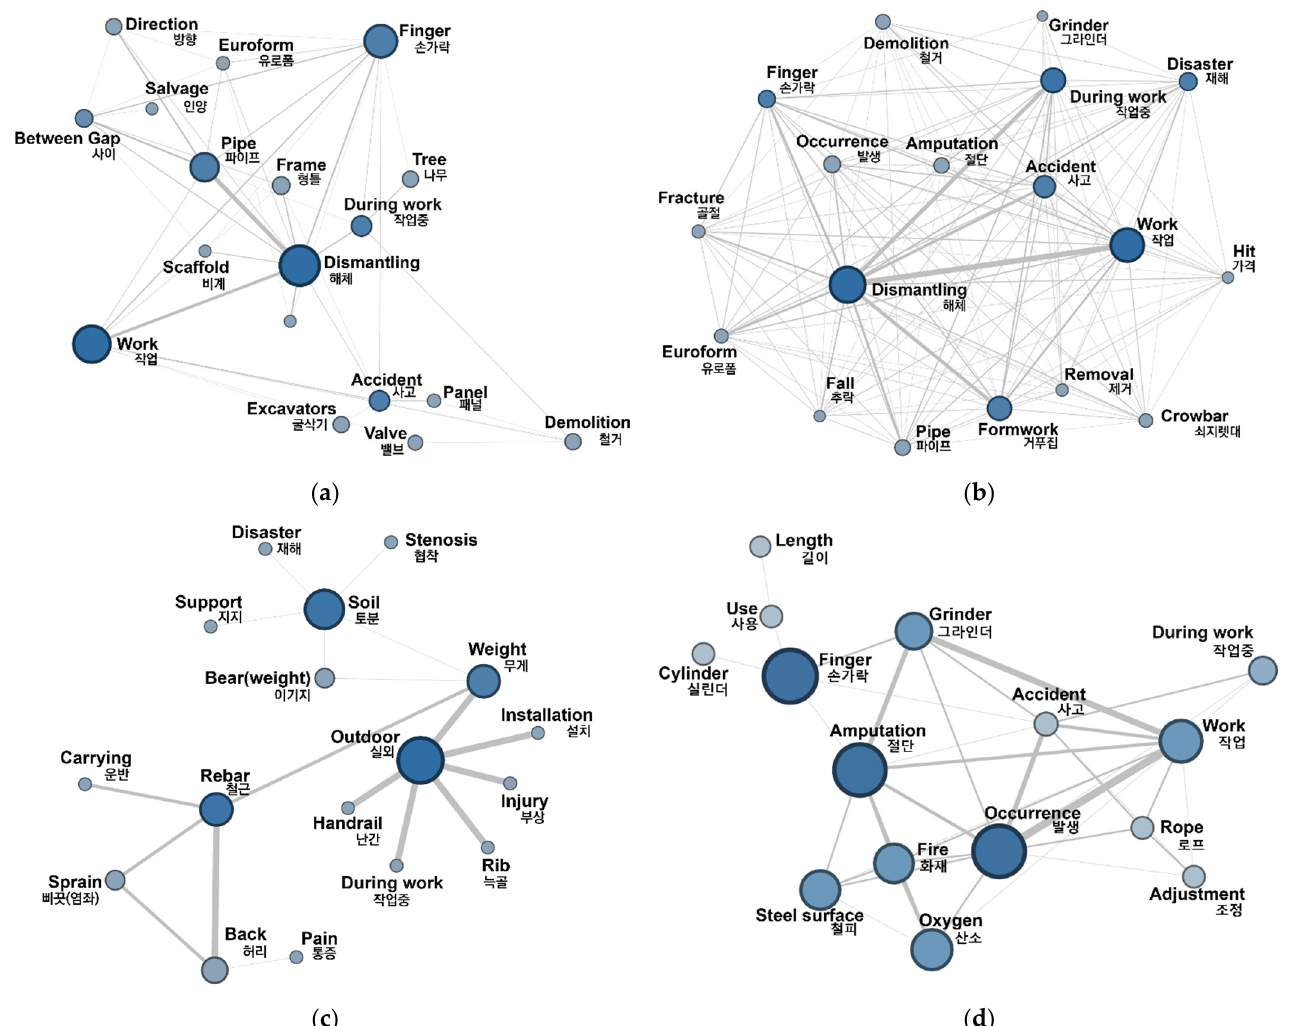
Figure 6. Semantic network analysis diagram of key factors affecting unsafe acts factor: ( a ) TE-PER semantic network diagram; ( b ) TE-SBE semantic network diagram; ( c ) PP-PER semantic network diagram; ( d ) PIO-SBE semantic network